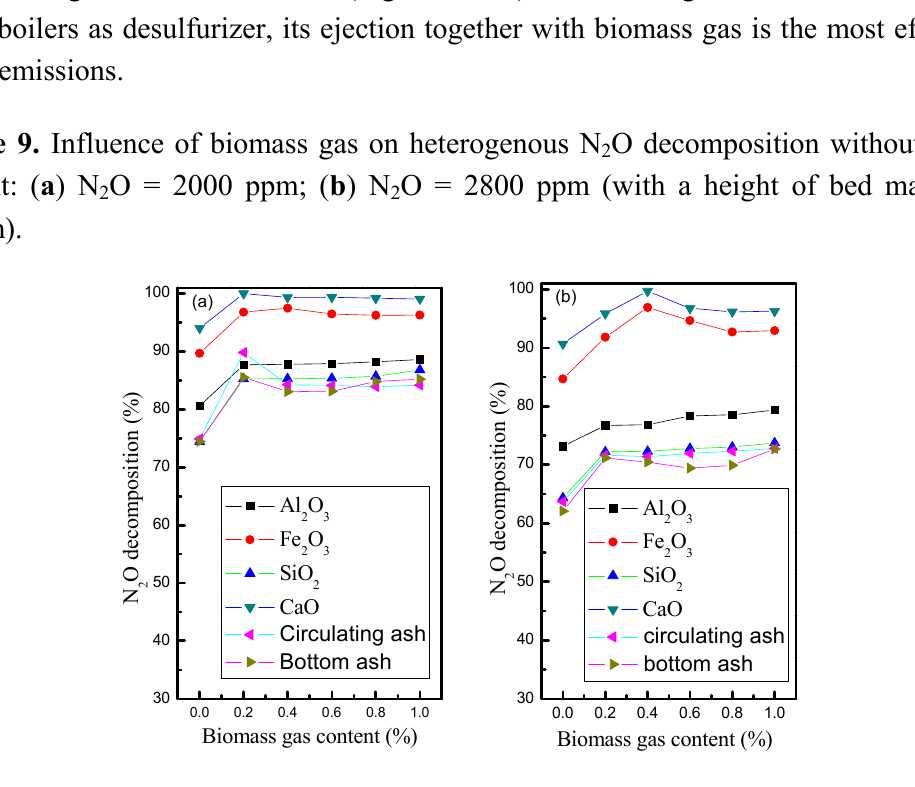
O decomposition with oxygen 2 O = 2800 ppm (with a height of bed material 2